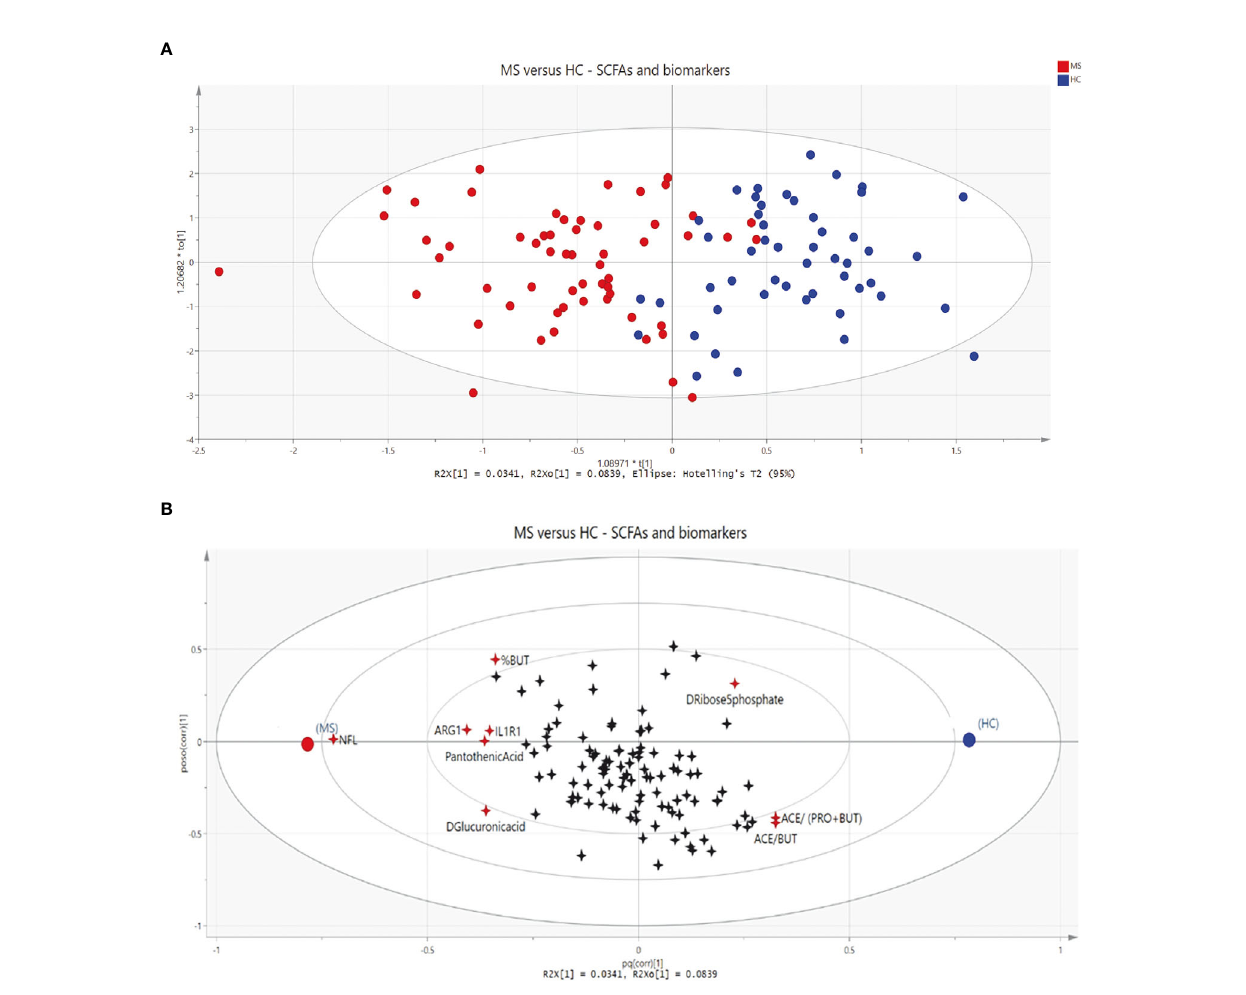
FIGURE 4 | (A) Score scatter plot displaying group separation between patients with multiple sclerosis (MS, red circles) and healthy controls (HCs, blue circles) based on short-chain fatty acids; biomarkers of in fl ammation and metabolites. Each circle represents one participant. (B) Loading scatter plot showing changes in short-chain fatty acids (SCFAs), biomarkers of in fl ammation and metabolites. Groups are shown as circles (MS, red; HCs, blue), and variables as 4-point stars. Discriminating variables are marked in red. NFL, neuro fi lament light chain; ARG1, arginase 1; IL1R1, interleukin-1 receptor type 1; %BUT, proportion of butyrate; ACE/(PRO+BUT), acetate/(propionate + butyrate); ACE/BUT,